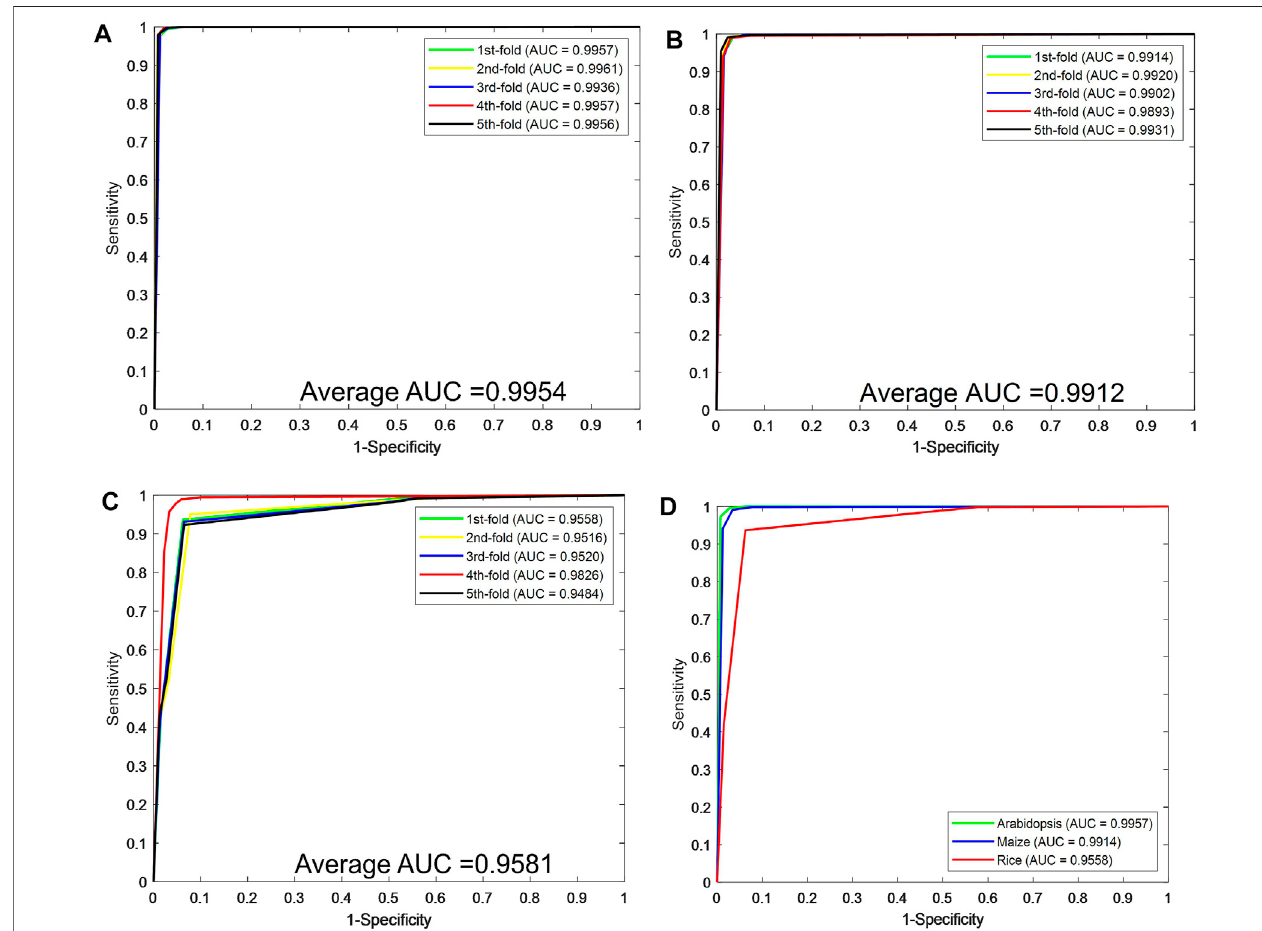
FIGURE2| ThepredictiveperformanceoftheproposedCPIELAmethodvia fi vefoldcross-validation. (A – C) TheReceiverOperatingCharacteristic(ROC)curvesof Arabidopsis thaliana , Zea mays , and Oryza sativa datasets. (D) The ROC curves performed by the CPIELA method on three plant PPIs datasets.